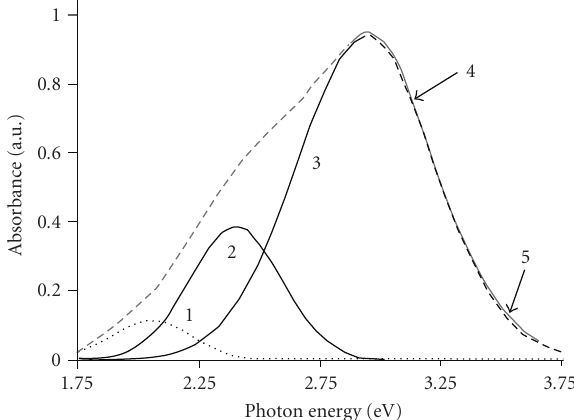
Figure 13: Deconvolution of spectrum 3 of Figure 12 (curve 5 herein). Band 4 represents the convolution sum of curves 1, 2, and 3. Reproduced with permission from [67]. Copyright (2006) Amer- ican Chemical